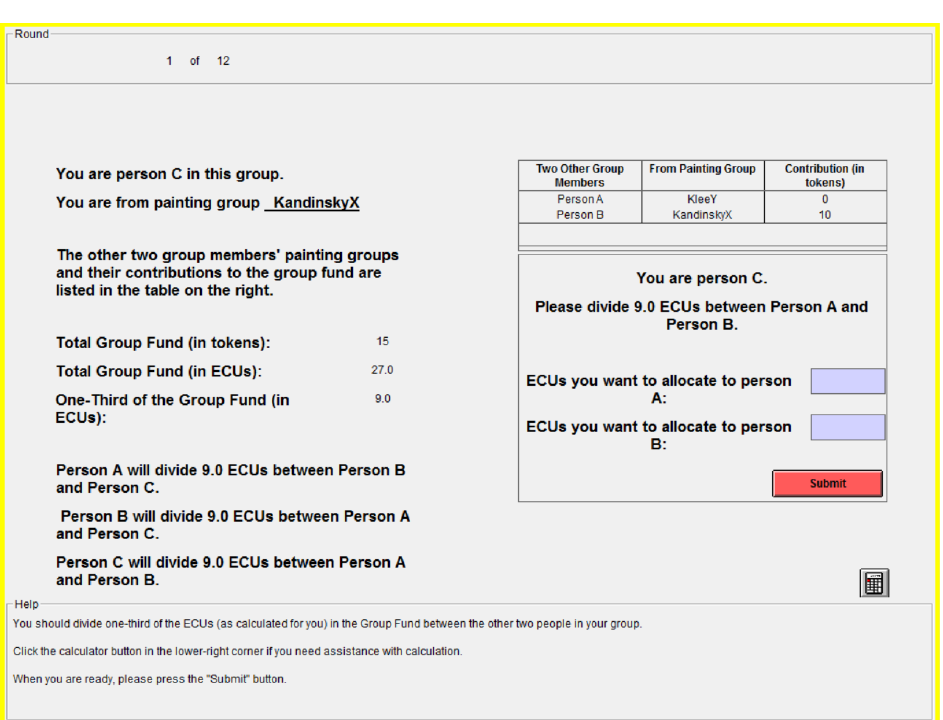
Figure A2. Allocation